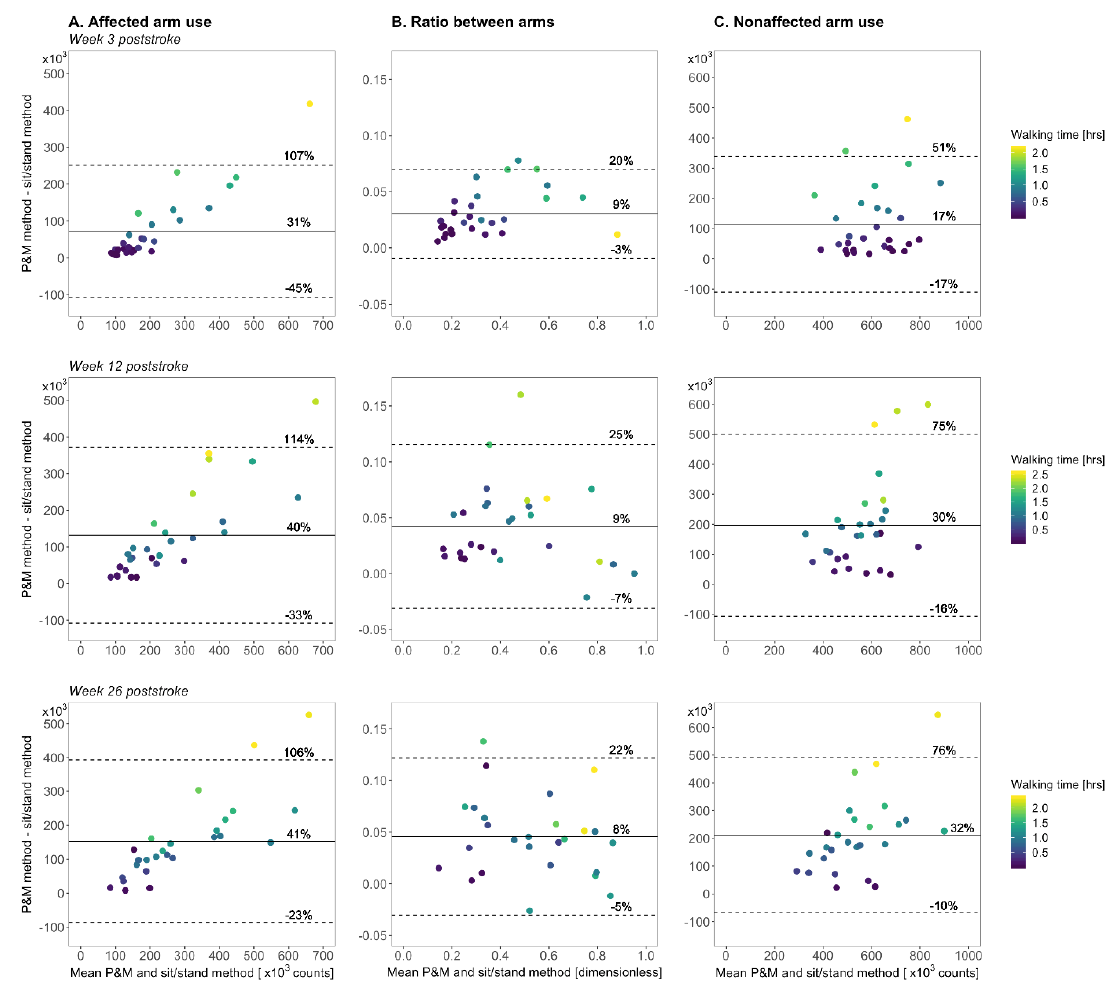
Figure 4. Bland and Altman plots showing the mean arm use outcome of the P&M method and the sit/stand method versus the difference in arm use outcome between the methods. The horizontal line indicates the mean difference between methods (D), and the dashed horizontal lines represent the limits of agreement (LOA). The D and LOA are expressed as a percentage of the mean arm use outcome of the P&M method. Bland and Altman plots are shown for week 3 poststroke (upper row), week 12 poststroke (middle row), and week 26 poststroke.